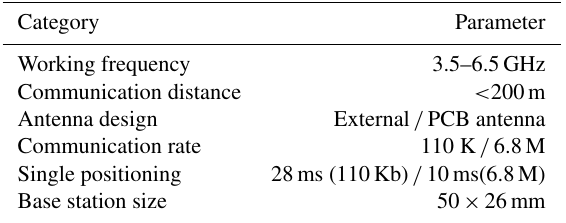
Table 1. Positioning module development board. Note: PCB – printed circuit